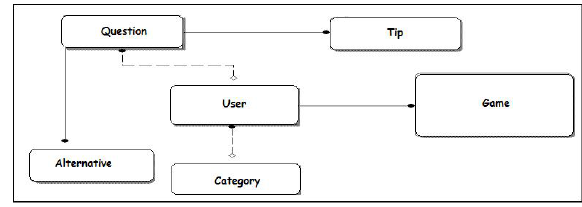
Figure 5. Logical model of the database.